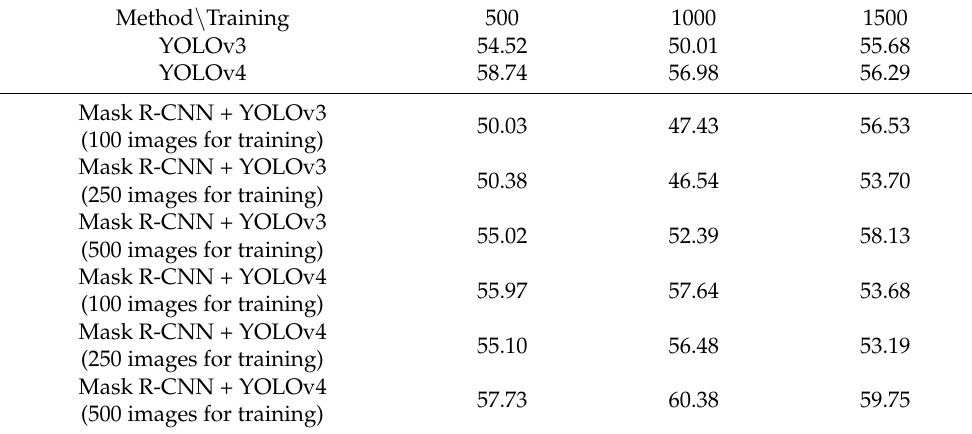
Table 9. Method Comparison (mAP = 0.5, Testing sets =